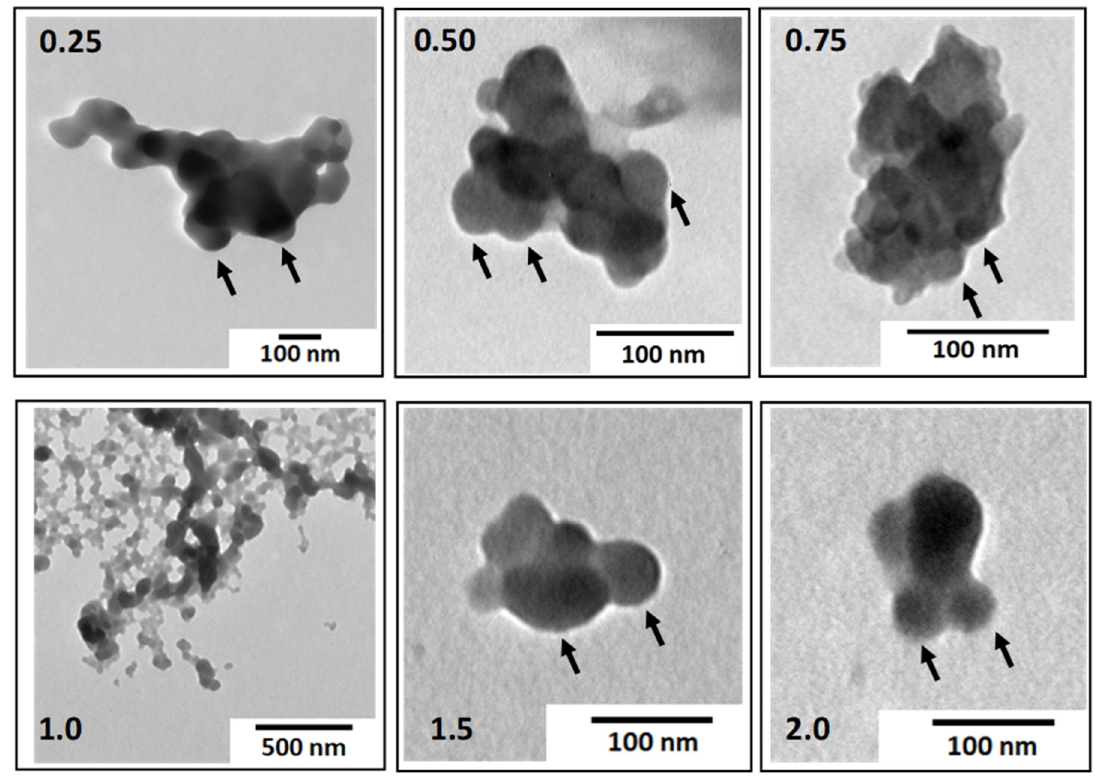
Figure 6 . TEM images showing the morphology of PEC particles obtained by complexing PDADMAC with PSS100% at various molar charge ratios Z(+/ − ) comprised between 0.25 and 2. The arrows highlight the substructure of PEC particles where primary complexes can be observed.